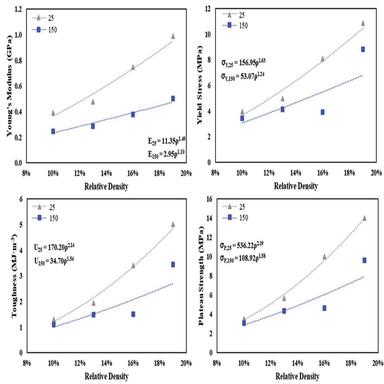
The mechanical properties of the cellular structures plotted against relative density for the testing conditions and fitted through the power law.